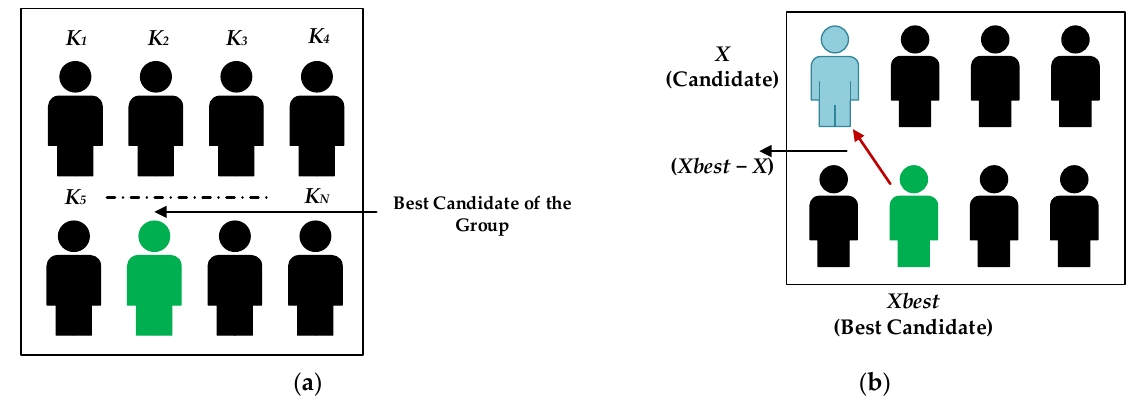
Figure 5. ( a ) Best candidate of the group. ( b ) Best fitness of the candidate in the SGO algorithm.